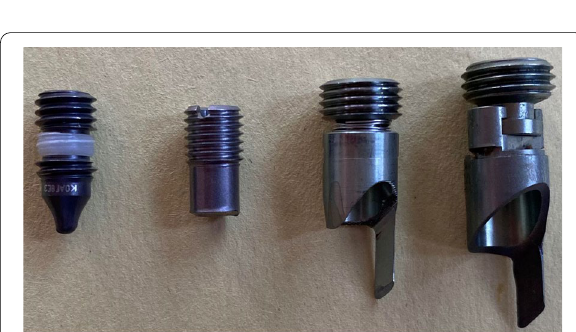
Fig. 5 Pictured from left to right are the set screws for the Gamma 3, Intertan, TFNa, and TFN cephalomedullary nails. The set screws for the TFNa and TFN are unique as they have two separate pieces. The components are divided into the upper portion, or lock drive, and the lower portion, or lock prong. The lock prong in the TFNa appears smaller and thinner in size than its predecessor, the TFN. A spring has also been added in the